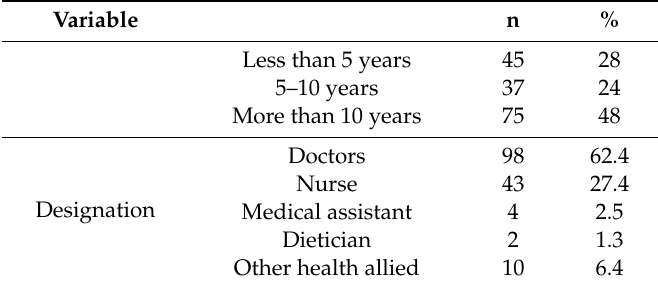
Table 3. Length of service and designation of healthcare